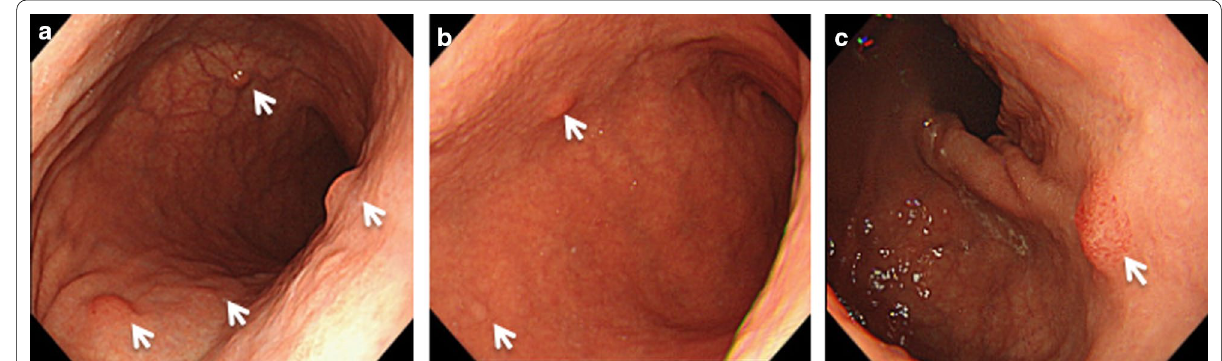
Fig. 1 Pretreatment endoscopic findings. EGD shows an atrophic pattern and many 3–5 mm submucosal tumor-like elevated lesions around the gastric body ( a, b ) and fundus ( c ) (white